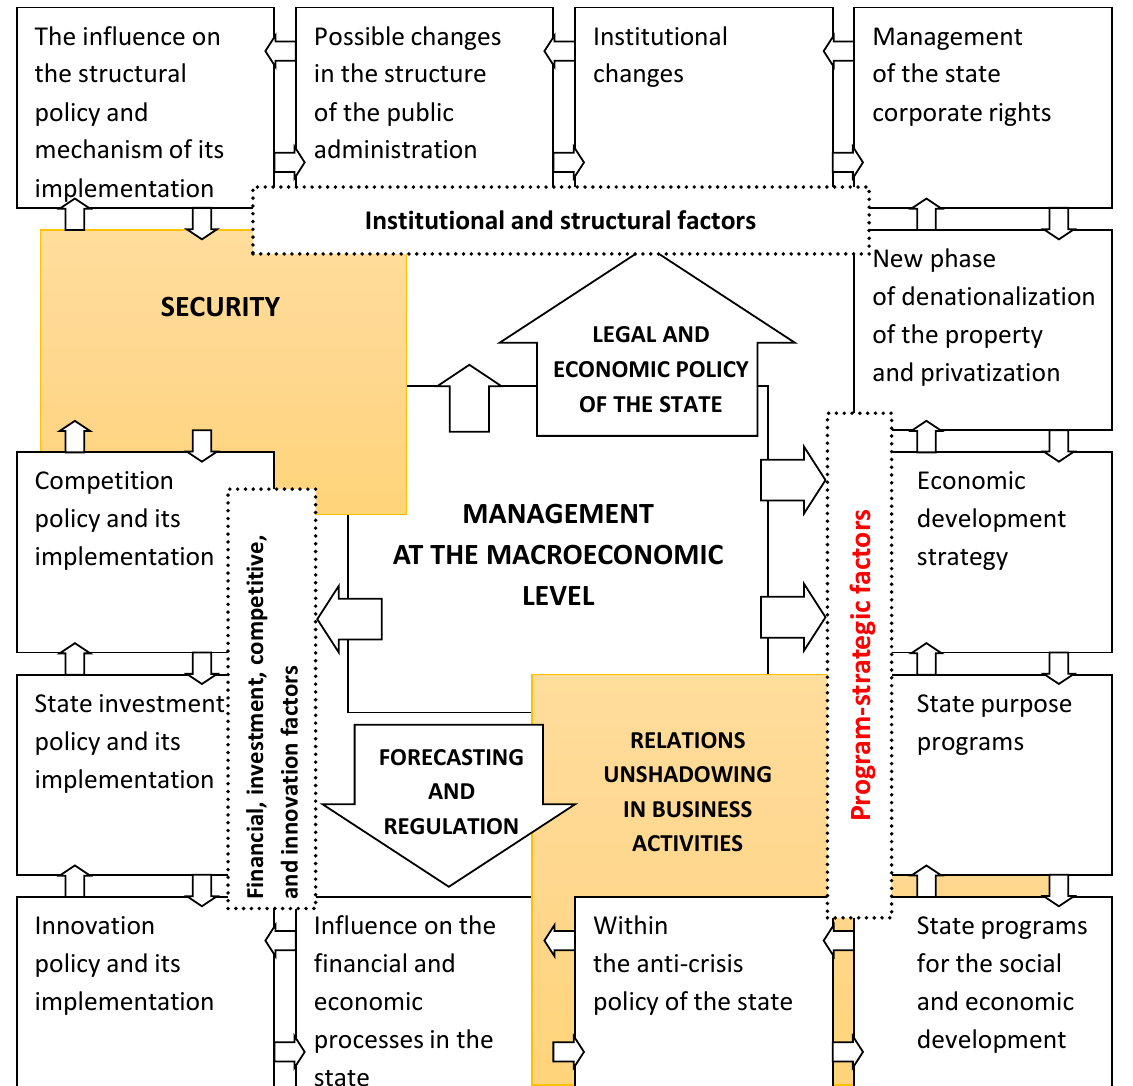
Figure 2. The relations unshadowing in business activities integrated into security factors within